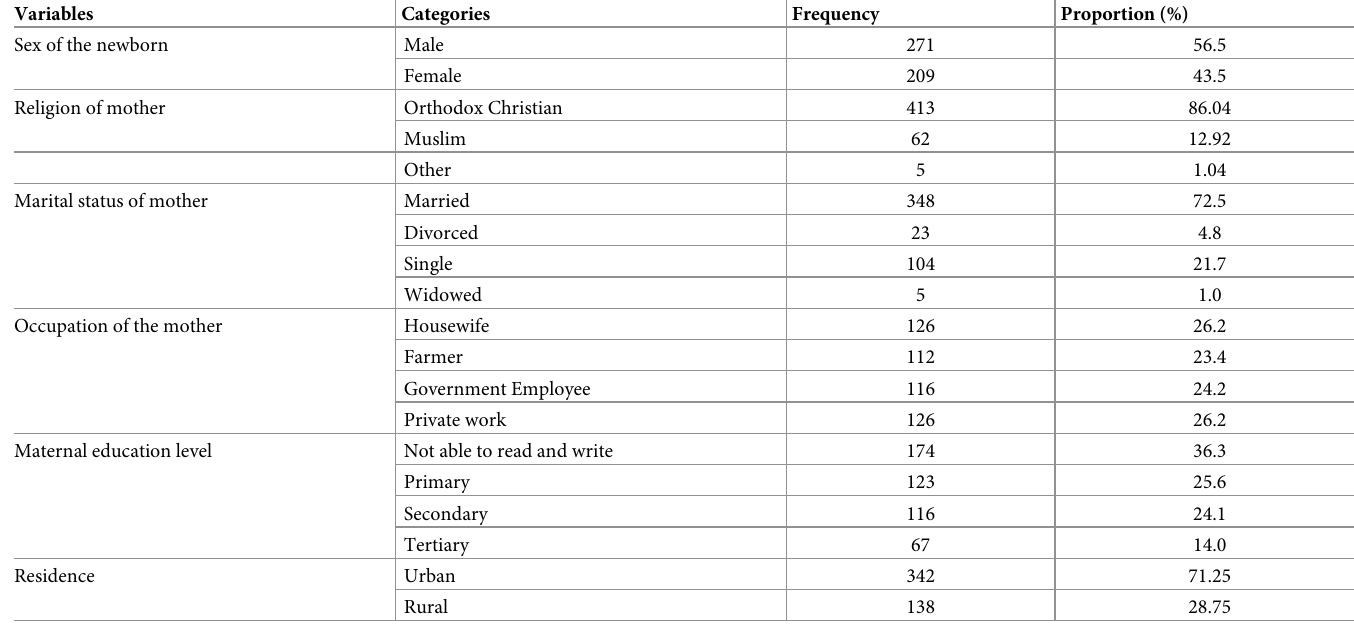
Table 1. Newborns and maternal socio-demographic characteristics in selected hospitals of Northwest, Ethiopia.